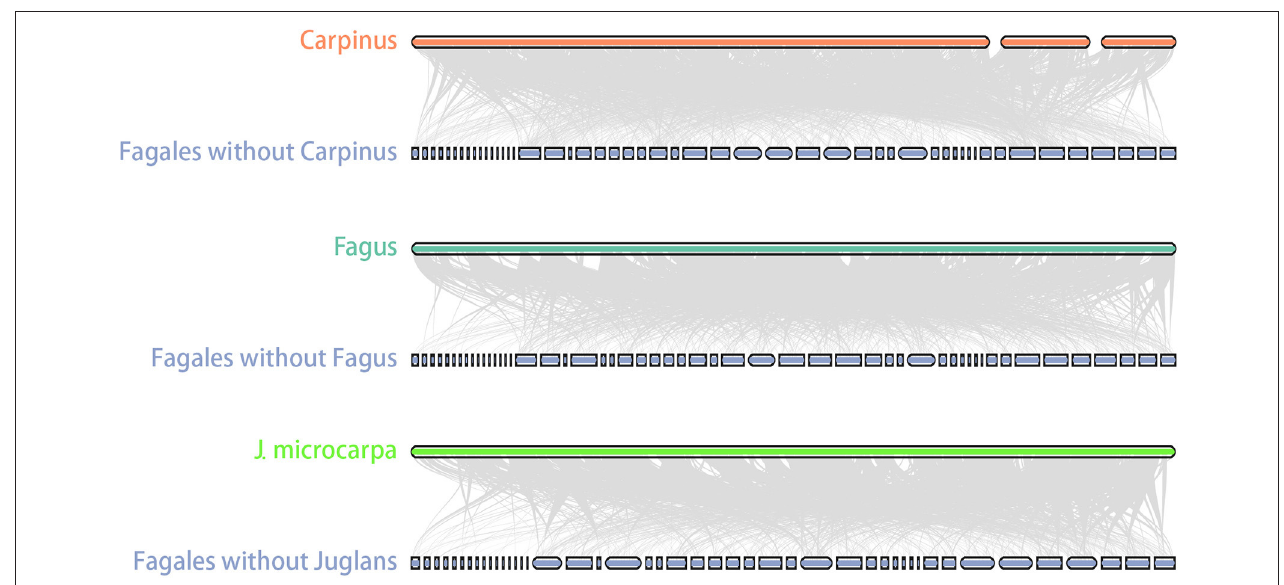
FIGURE 6 | Carpinus mitogenome shared more homologous sequences with other Fagales. Homologous sequences between Carpinus and other Fagales mitogenomes were linked by gray lines. GSSs shared no homologous with others so that it would leave blank spaces that had no connections. Carpinus showed little blank spaces, and it proved that it has more homologous sequences with other Fagales. Fagus and J. microcarpa were used as